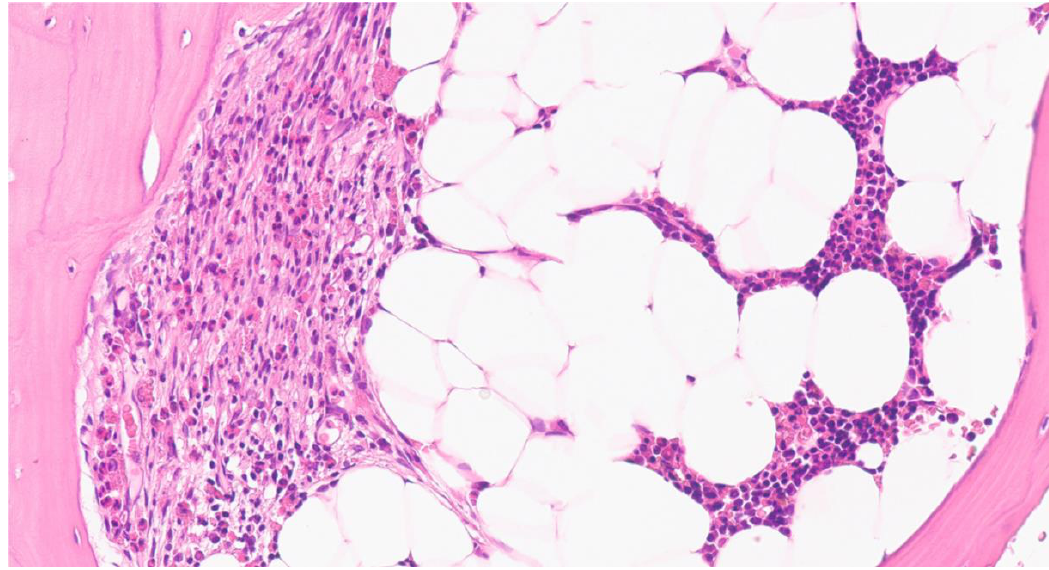
Figure 4. Case 4. Focal paratrabecular spindle-shaped MCs associated with numerous eosinophils in the BM (hematoxylin and eosin, ×200).